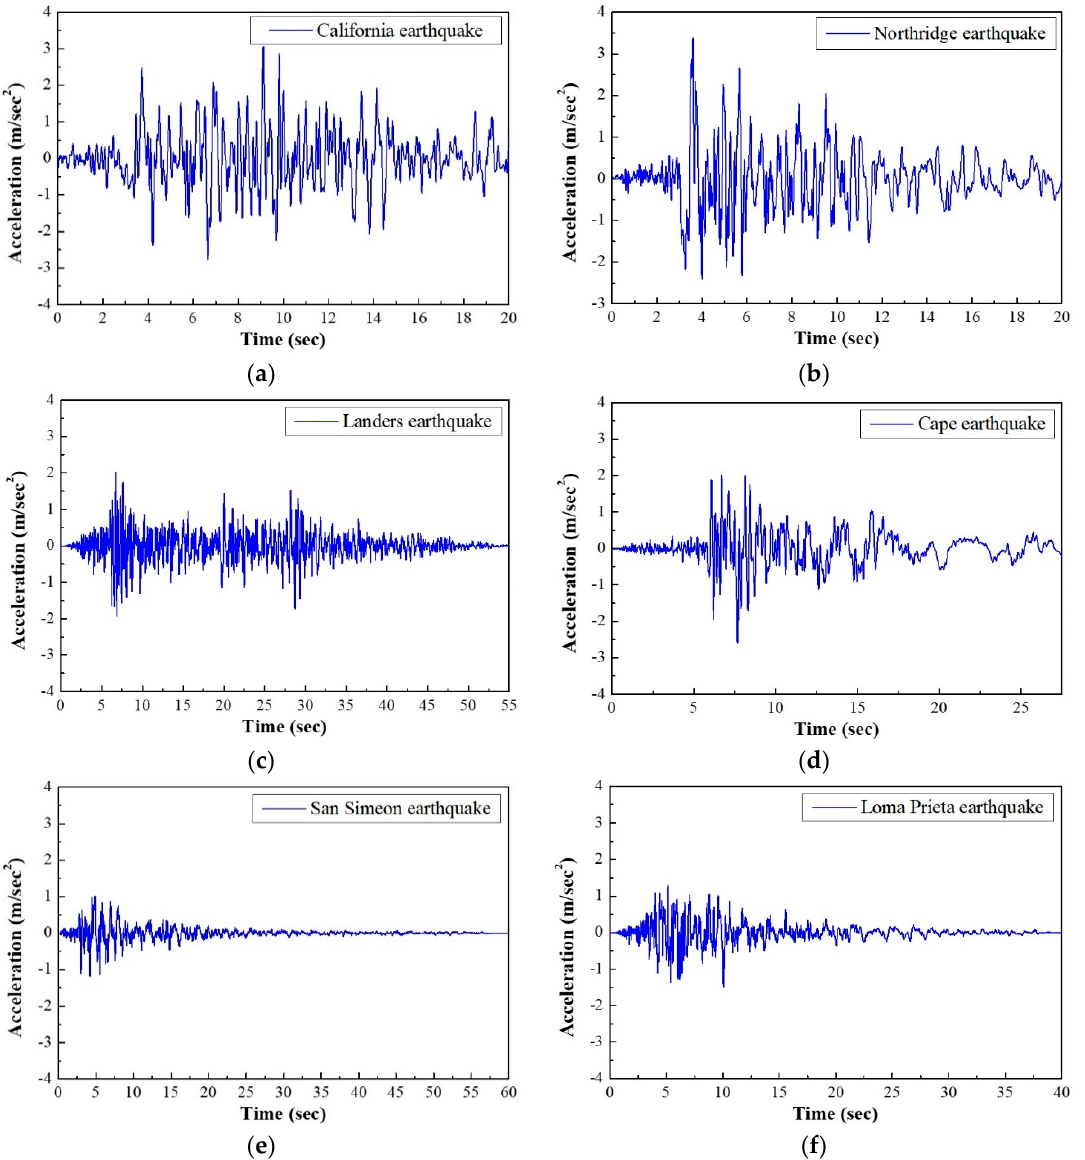
Figure 5. Seismic loads for the numerical analysis: ( a ) California earthquake; ( b ) Northridge earthquake; ( c ) Landers earthquake; ( d ) Cape earthquake; ( e ) San Simeon earthquake; ( f ) Loma Prieta earthquake.